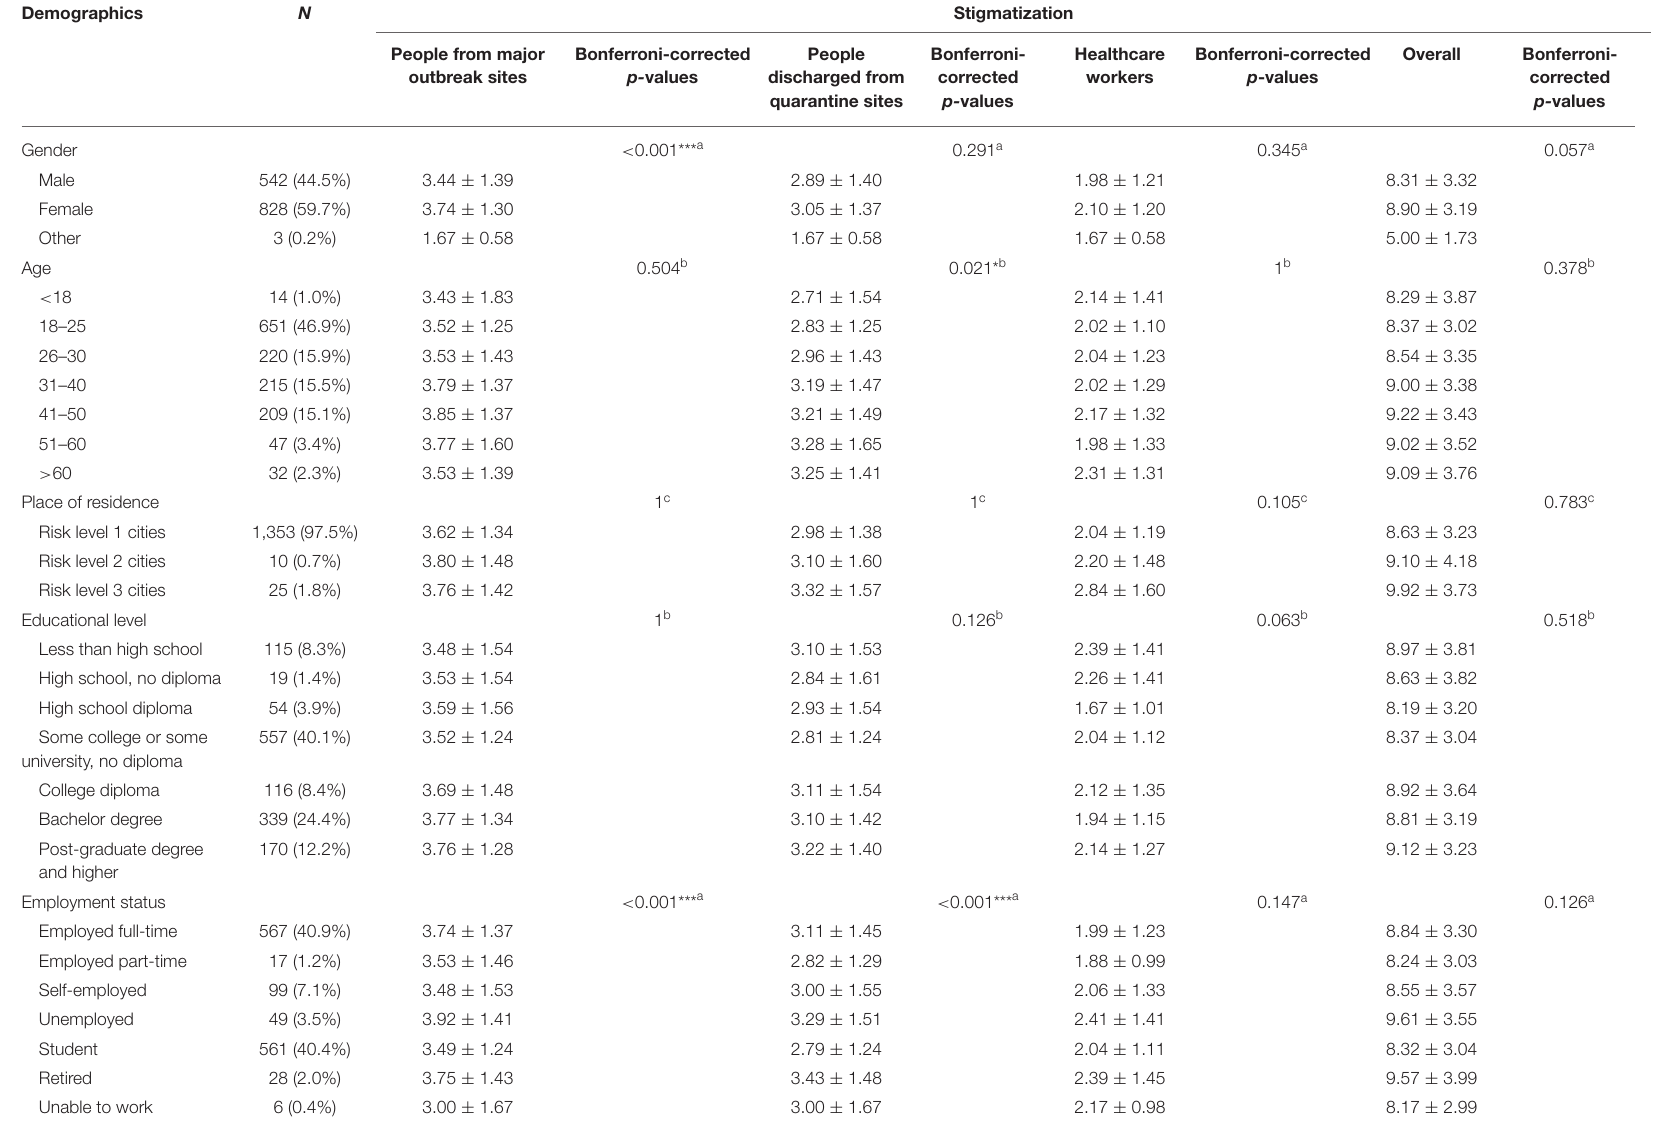
TABLE 1 | Demographic